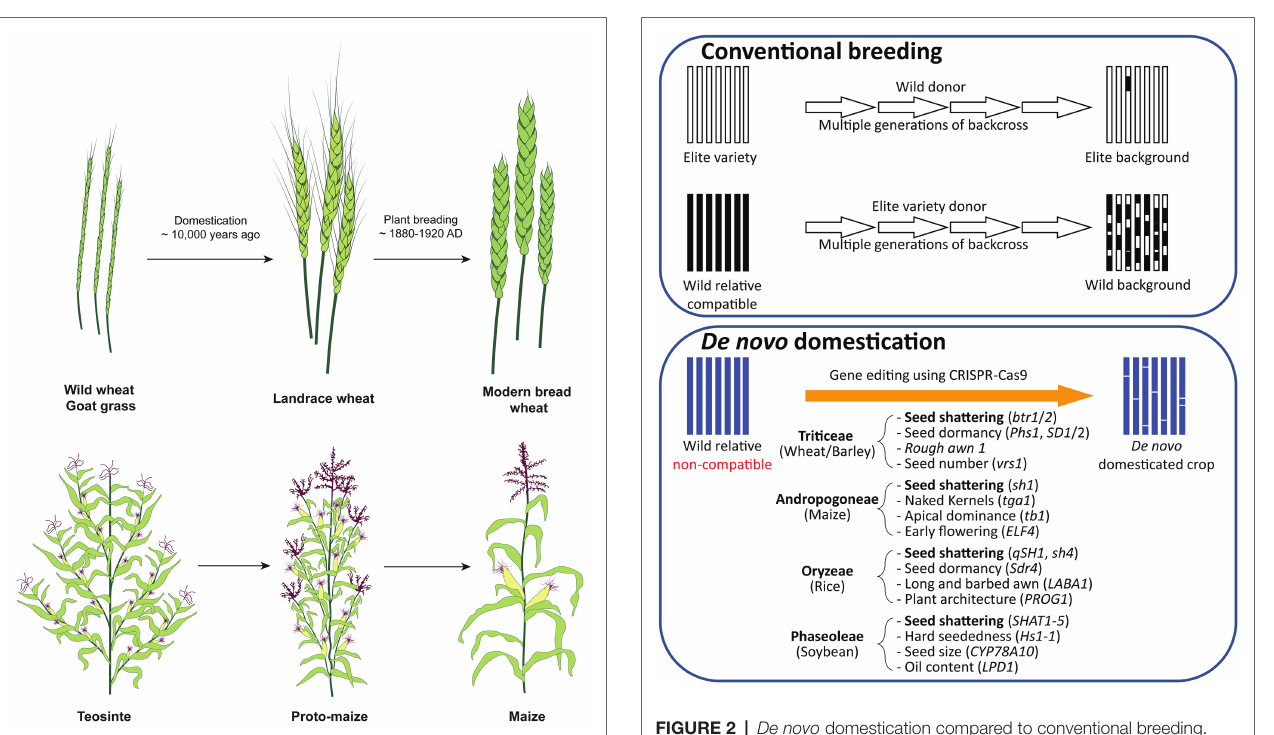
FIGURE 2 | De novo domestication compared to conventional breeding. Comparison of the traditional breeding approach using backcrossing of the elite line with its wild relative with the molecular de novo domestication approach using the genome editing technique. Examples of potential target genes to be edited in the process of de novo domestication of wild relatives are indicated below the